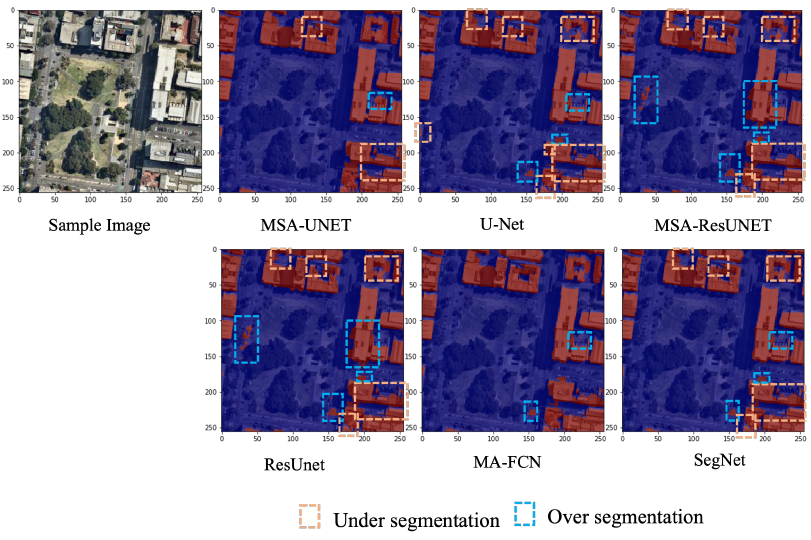
Figure 10. Sample results from the MSA-UNET, U-Net, MSA-ResUNET, ResUNET, MA-FCN, and SegNet (left-right) on the Melbourne Building dataset (TR2). The orange and blue region highlights the pixels affected by under- and over-segmentation,